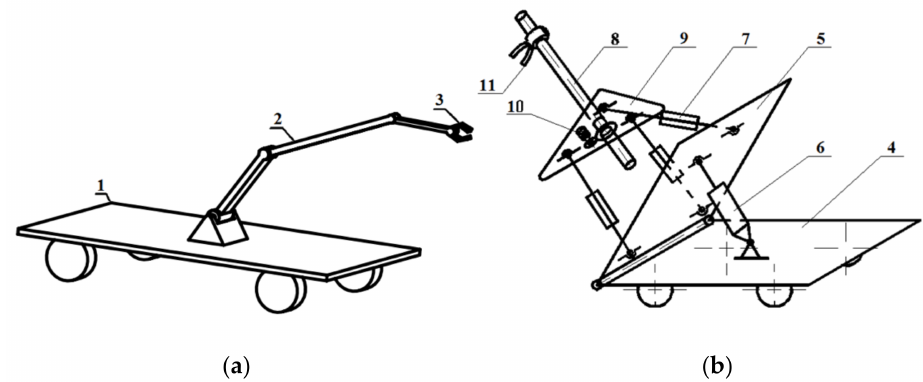
Figure 1. Diagram of a multi-robotic system—( a ) serial manipulator, ( b ) parallel manipulator.